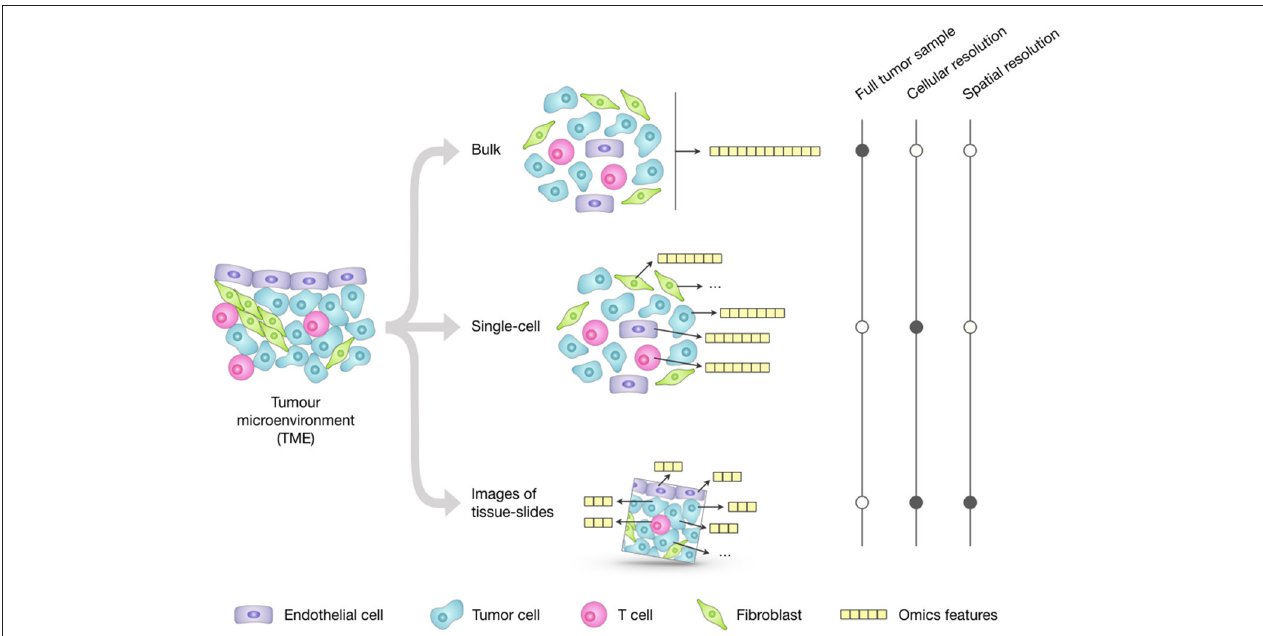
FIGURE 1 | Overview of the main approaches for multi-omics profiling of the tumor microenvironment (TME). Omics datasets can be generated from bulk tumor samples; this approach is the most standardized and widely used and provides a high-throughput representation of the molecular features (e.g., genome, transcriptome, proteome) of the TME as a whole. Unlike the averaged representation provided by bulk approaches, single-cell technologies allow generating omics profiles of each individual cell; however, their costs and technical complexity currently limit the throughput in terms of number of features and total cells that can be assayed. Emerging imaging techniques can generate omics datasets from tumor-tissue slides that retain the cell spatial resolution; they have cellular or subcellular resolution but their throughput is significantly lower compared to the other two approaches and the resulting images only represent a restricted 2D snapshot of the